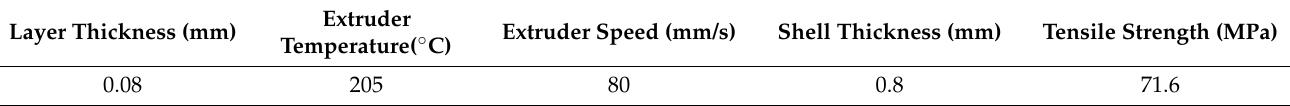
Figure 2. ASTM D638-10 tensile test specimen reinforced with solid carbon fiber rods. Table 2. Reference sample parameters